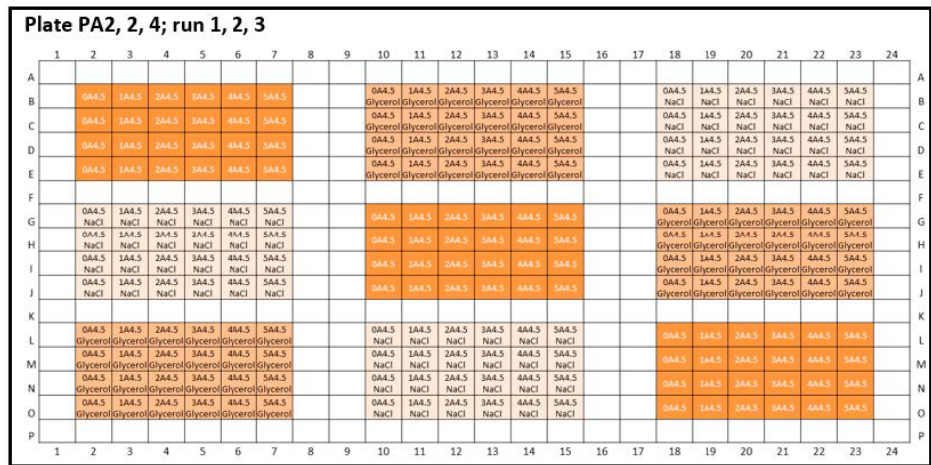
Figure A2. Experimental plate designs for inter-plate variability. Peptide-12 (P): three 384-well plates were analyzed: PA2-4: A4.5 = acetate buffer, pH 4.5; the concentration series were arranged horizontally; 4 replicates were positioned vertically. (1 = 2 mg/mL, 2 = 4 mg/mL, 3 = 6 mg/mL, 4 = 8 mg/mL, 5 = 10 mg/mL API, and 0 = placebo). Glycerol (orange) and sodium chloride (light orange) were added as tonicity agents, and formulations without tonicity agents were marked in dark orange.